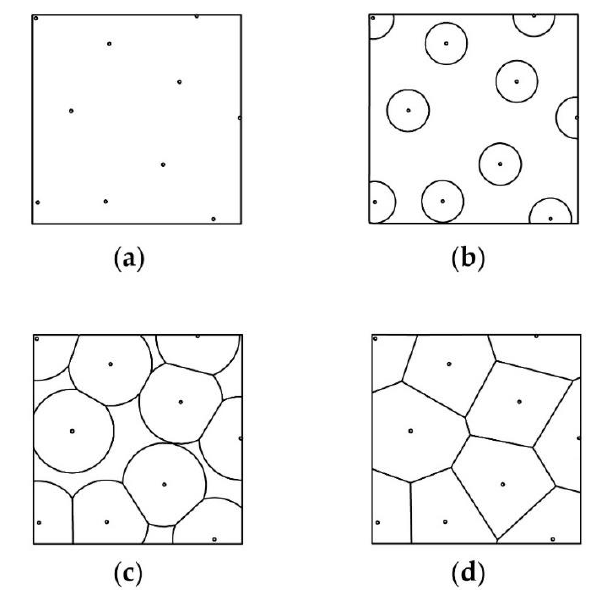
Figure 3. The formation of an ordinary Voronoi diagram from a finite set of points within a finite 2D space: ( a ) two-dimensional Cartesian space with a finite set of points; ( b ) expanding circles drawn around each center point; ( c ) circles coming into contact and linear boundaries are formed; ( d ) no further expansion is possible and convex polygons are formed.